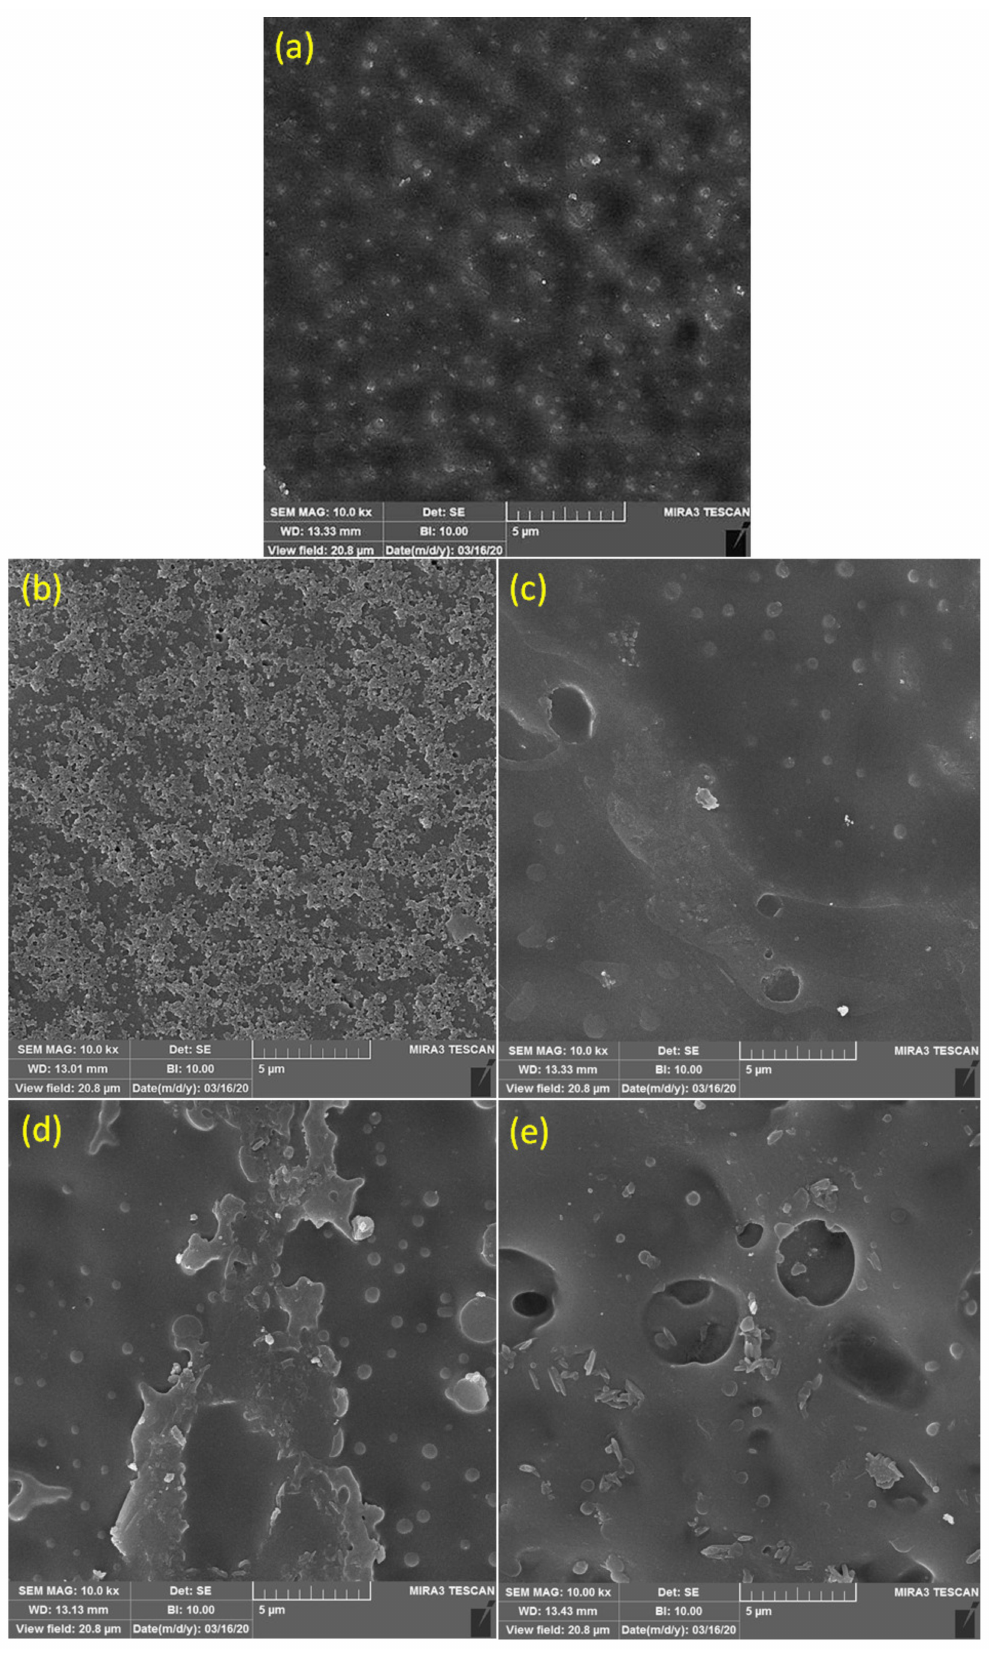
Figure 4. SEM images of the: ( a ) Blank PVC before irradiation and ( b ) blank PVC, ( c ) PVC + 1 , ( d ) PVC + 2 and ( e ) PVC + 3 , after